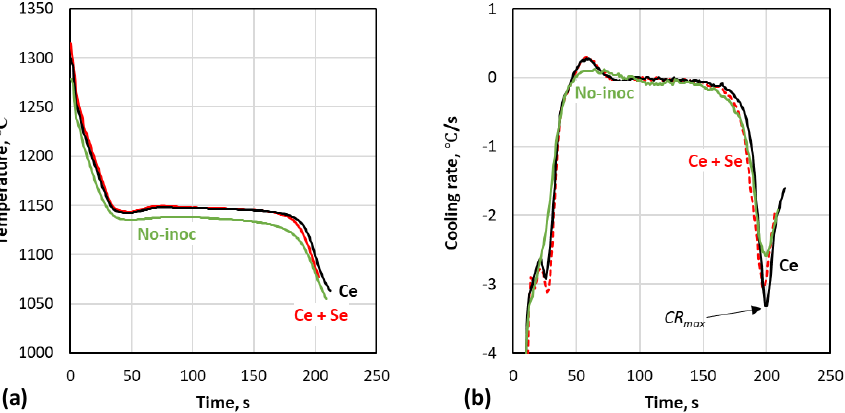
Figure 2. Cooling curves ( a ) and their first derivatives ( b ) from Heat 2 showing the effect of inocula- tion in increasing the maximum cooling rate, CRmax, at the end of solidification. After cooling to room temperature, the cups were sectioned and prepared (ground and polished) for metallographic examination. A total of 10 different fields were taken for each sample in order to analyze the morphology of the spheroidal graphite by optical microscopy. Image processing was performed by means of the Image J software to determine the nodule count. The minimum size considered when counting graphite particles was a surface of 25 µ m 2 , which gives a diameter of 3.36 µ